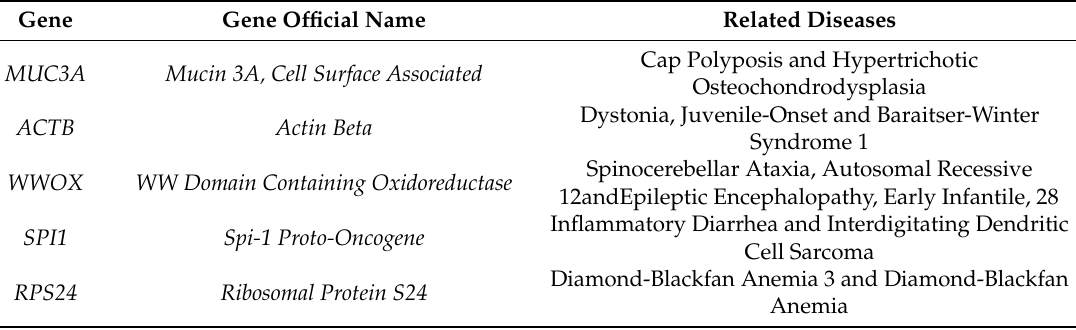
Table 5. The top five genes selected by LJELSR for the colon